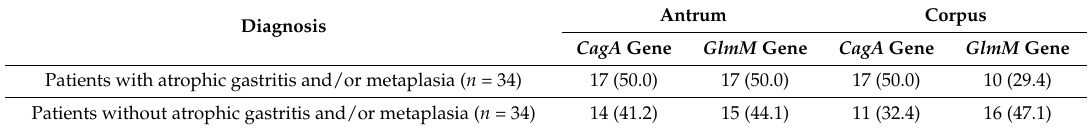
Table 5. Association between patients with atrophic gastritis and/or metaplasia and H. pylori (number and %). Antrum Corpus Diagnosis